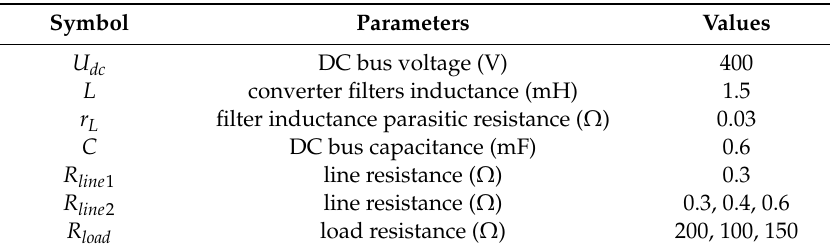
Table 2. Parameters of the control system.